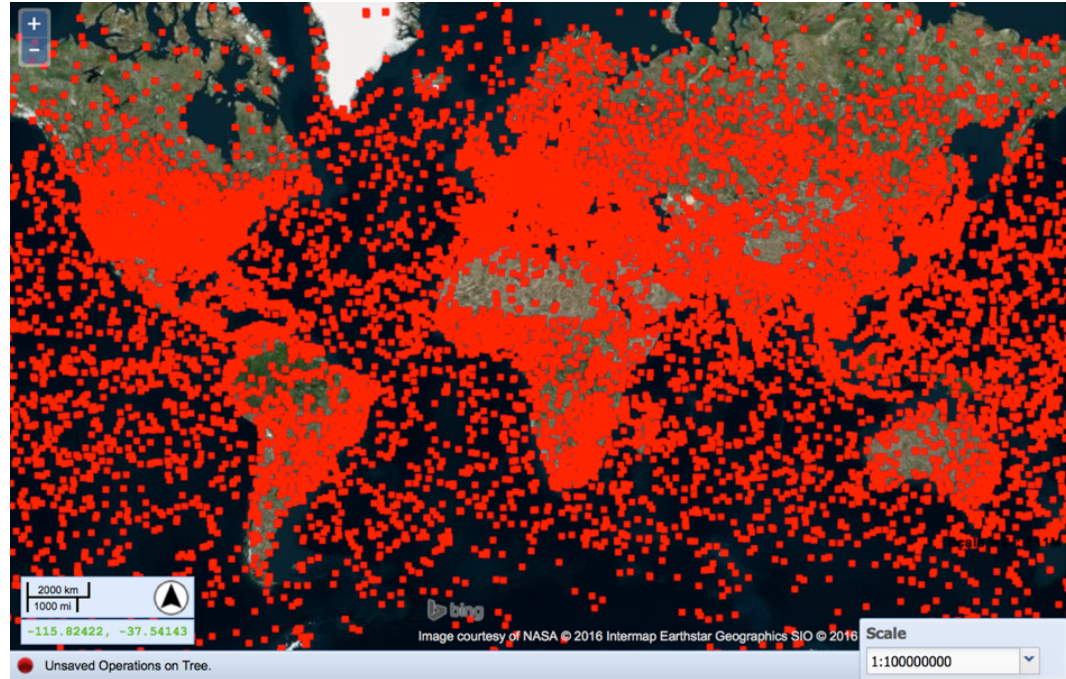
Figure 2. Sites of networks assessed for GAIA–CLIM. Each location denotes an observational asset capable of measuring one or more target ECVs at the surface, near surface or through much of the atmospheric